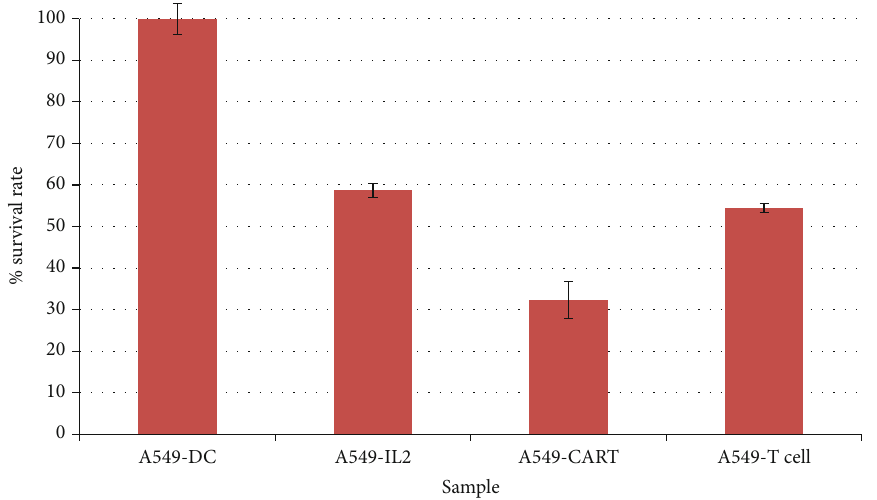
Figure 6: Results of T-cell and CAR-T cell toxicity test on A549 cells.